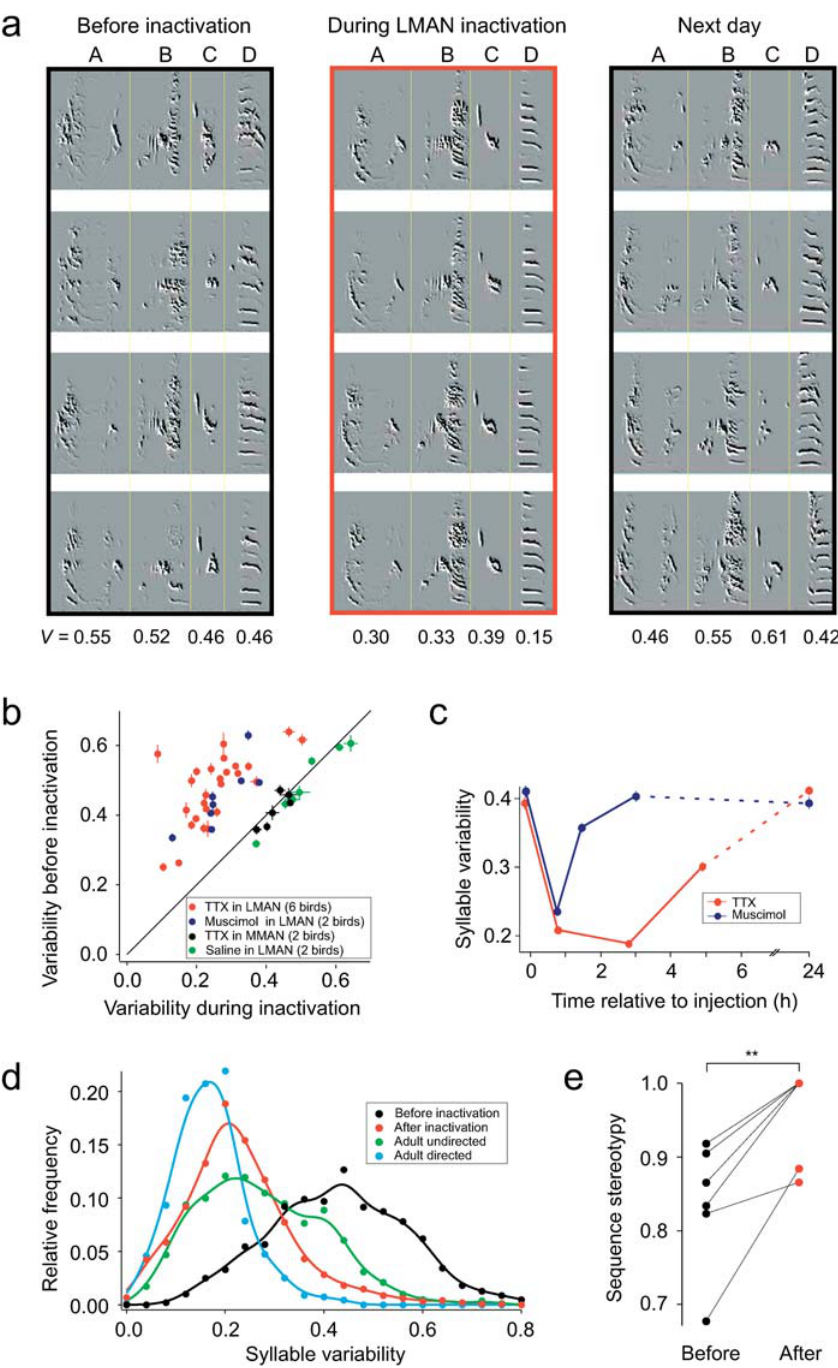
Figure 2. Analysis of the Effect of Bilateral LMAN Inactivation on Song Variability (A) Consecutive renditions of a repeating song motif of 0.5 s duration in a juvenile bird (59 dph) arranged vertically. Note the large variations in acoustic structure within individual syllables before LMAN inactivation (left). Following TTX injection into LMAN, the acoustic variability is dramatically reduced (middle), only to return to the original level by the following day (right). Numbers below each column indicate the variability index (See Material and Methods section) calculated for the four renditions of the syllables shown. (B) Scatter plot of variability scores before and during LMAN inactivation with TTX (red) and muscimol (blue). Also shown are results for bilateral TTX injection into MMAN (black; see text), and saline injection into LMAN (green). (C) Time course of variability reduction following TTX (red) and muscimol (blue) injections show a time dependence that reflects the known in vivo pharmacology of the respective agents. Data were averaged over four identified syllables and taken from the same bird over consecutive days (dph = 70 and 71; muscimol inactivation followed by TTX inactivation). (D) Distribution of variability scores for all syllables analyzed in the TTX and muscimol experiments (25 unique syllables, six birds) before (black) and during (red) LMAN inactivation in juvenile birds. Shown for comparison are the variability scores for adult zebra finch syllables (18 syllables, 4 birds; undirected song, green; directed song, light blue). Dots represent raw data, while the lines are smoothed running averages. (E) TTX inactivation of LMAN significantly increased syllable sequence stereotypy. Sequence stereotypy scores (see Materials and Methods) for six birds before (black) and after (red) TTX injections into LMAN. For comparison, the average stereotypy score for adult birds singing directed song was 0.95 ( n = 4 birds). DOI: 10.1371/journal.pbio.0030153.g002 PLoS Biology |